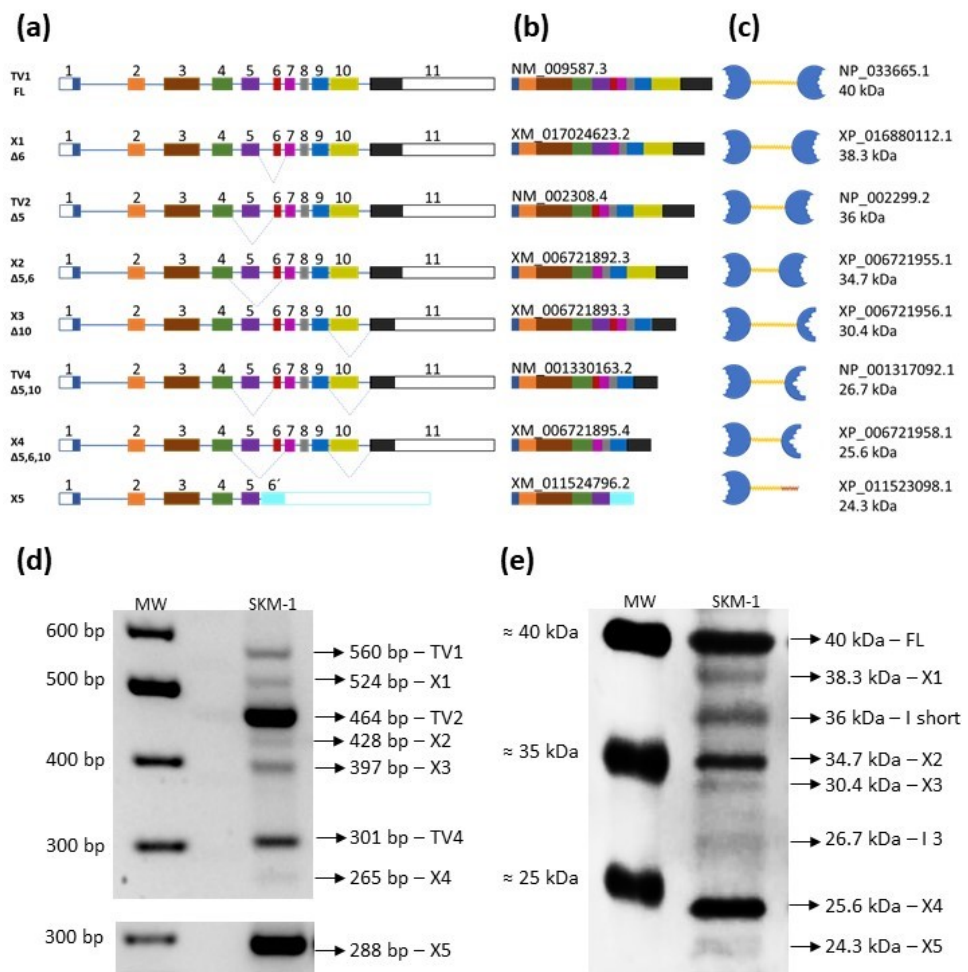
Figure 6. Overview of multiple variants of GAL-9 owing to alternative splicing of LGALS9 pre- mRNA. ( a ) Scheme of alternative splicing of exons 5, 6 and 10 in the various combinations. ( b ) structure of mature mRNA with identification from NCBI gene database; ( c ) structure of respective proteins with identification from the NCBI protein database. Almost every isoform (except variant X5) contains 2 CRDs (blue) that are connected by linker peptides (yellow). Alternative splicing of exons 5 and 6 affects the length of the linker peptide, while splicing of exon 10 leads to truncation of the second (C-terminal) CRD. TV X5 contains alternative exon 6 ′ , which contains a premature stop codon (TAA); thus, X5 comprises only 1 CRD and the peptide tail (protein struc- ture predicted). FL—full-length GAL-9, which is encoded by all 11 exons; ( d ) representative gel of LGALS9 mRNA PCR products detected by RT-PCR; ( e ) expression of respective GAL-9 protein isoforms detected by Western blot. The expression profiles of transcript variants and isoforms were similar for SKM-1 and MOLM-13 (data not shown). MW—marker of molecular mass; I— isoform.